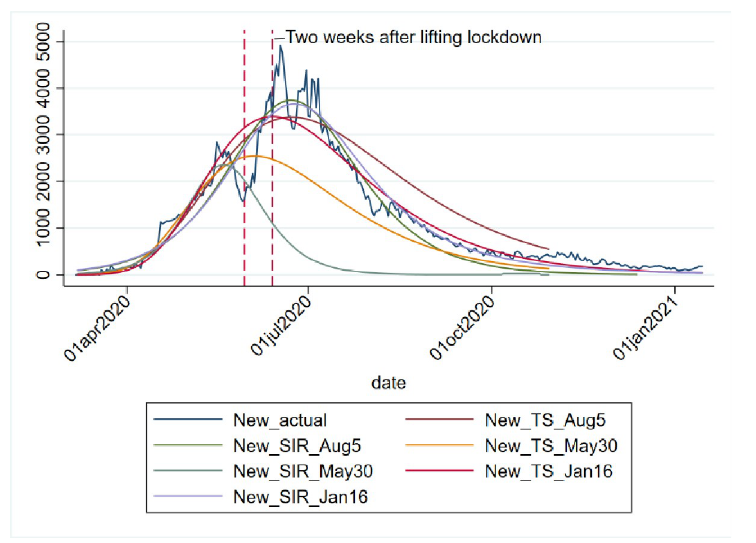
Fig 6. Projection of daily COVID-19 cases in KSA under various